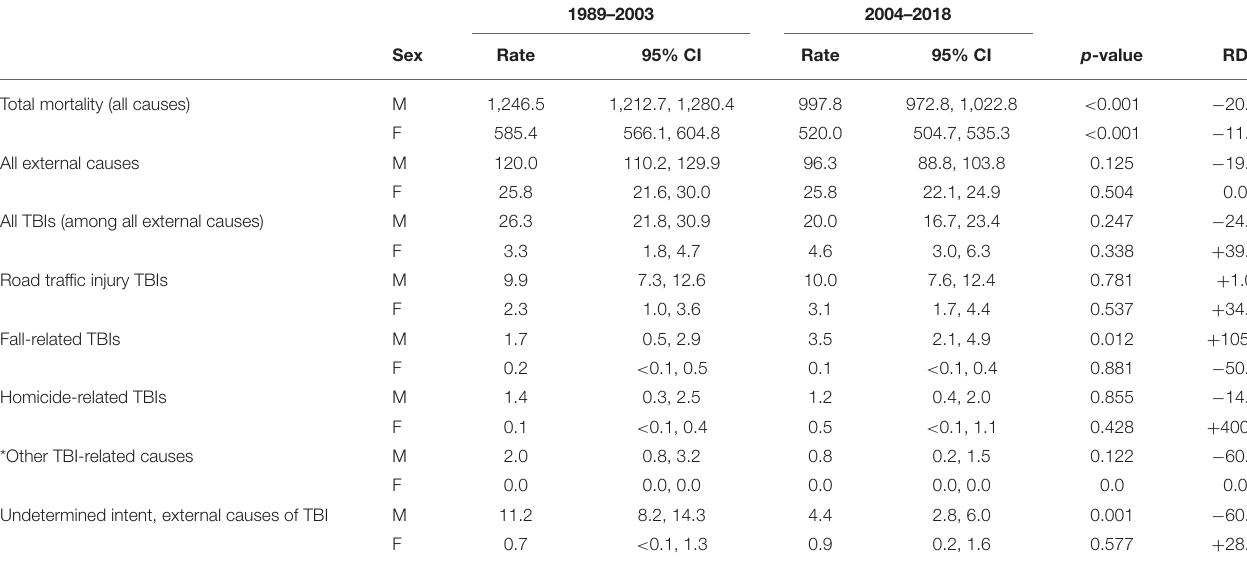
TABLE 2 | Age-standardised mortality rates for all causes, all external causes and leading specific TBIs during 1989–2003 and 2004–2018.